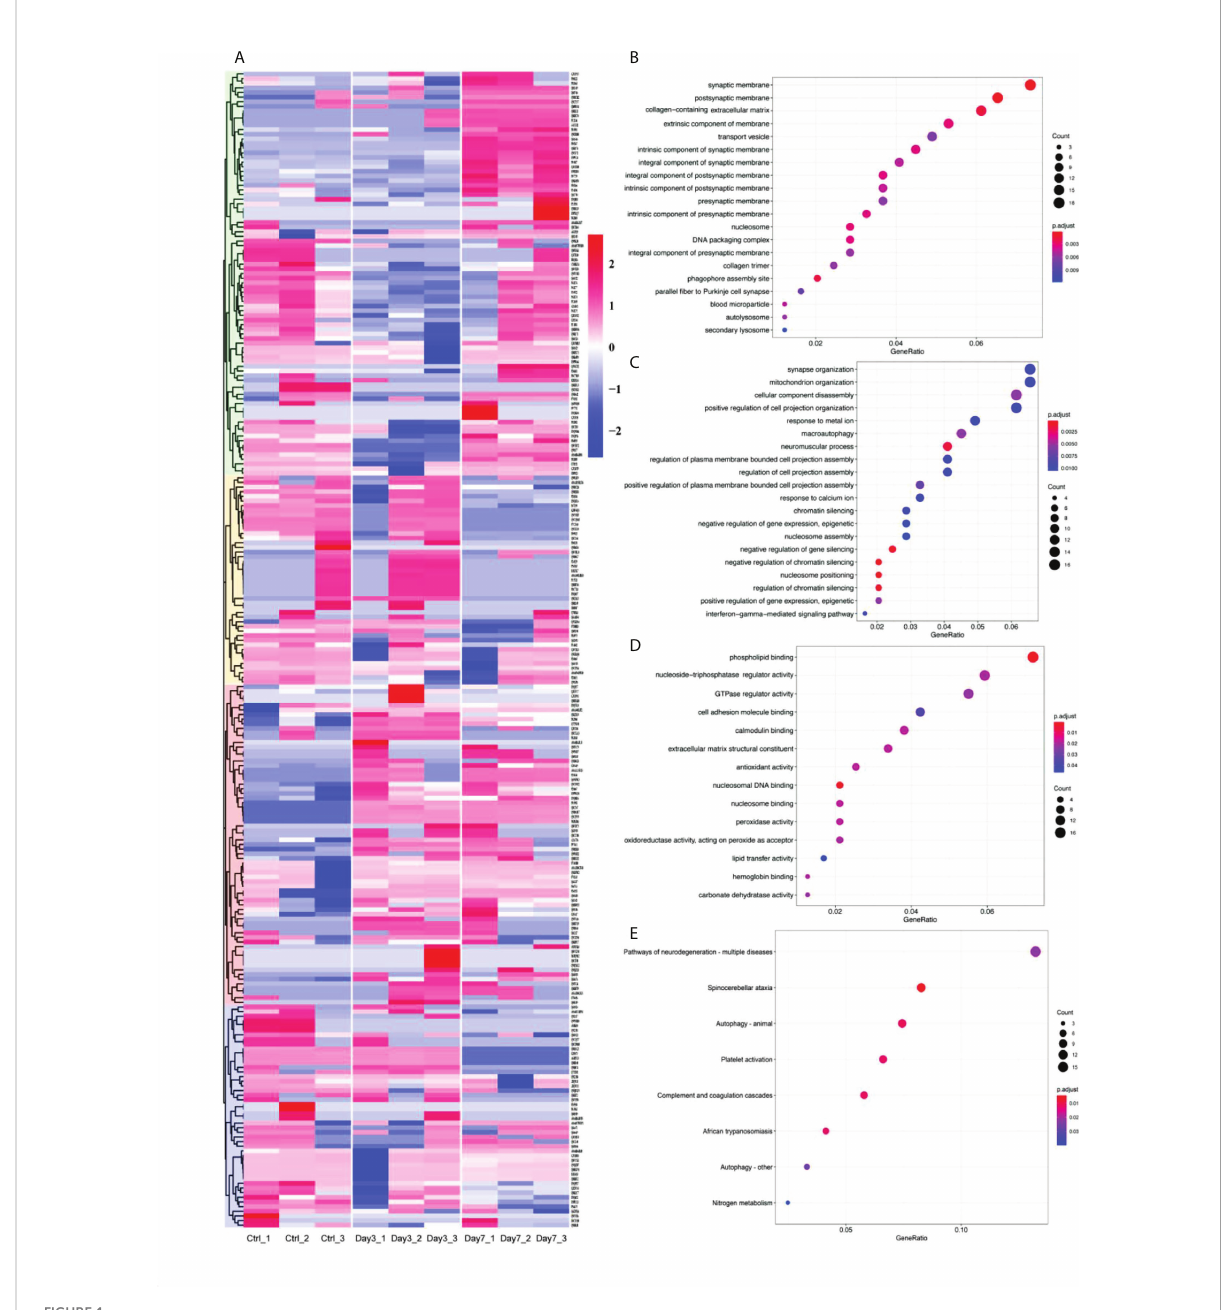
FIGURE 1 Altered protein expression in brain induced by vaginally infection with HVS-2. (A) Heatmap of differentially expressed proteins. Red represents upregulated proteins, blue downregulated proteins, with more intense colors representing more pronounced differences. (B-D) Partial results of GO function enrichment analysis, (B) affected cellular components, (C) biological process, and (D) molecular function. The size of circles is proportional to the level of enrichment. Red indicates the highest, blue indicates the lowest P value. (E) Some of the results of KEGG pathways enrichment. Again, the size of circles corresponds to the level of enrichment. Red indicates the high, blue low P